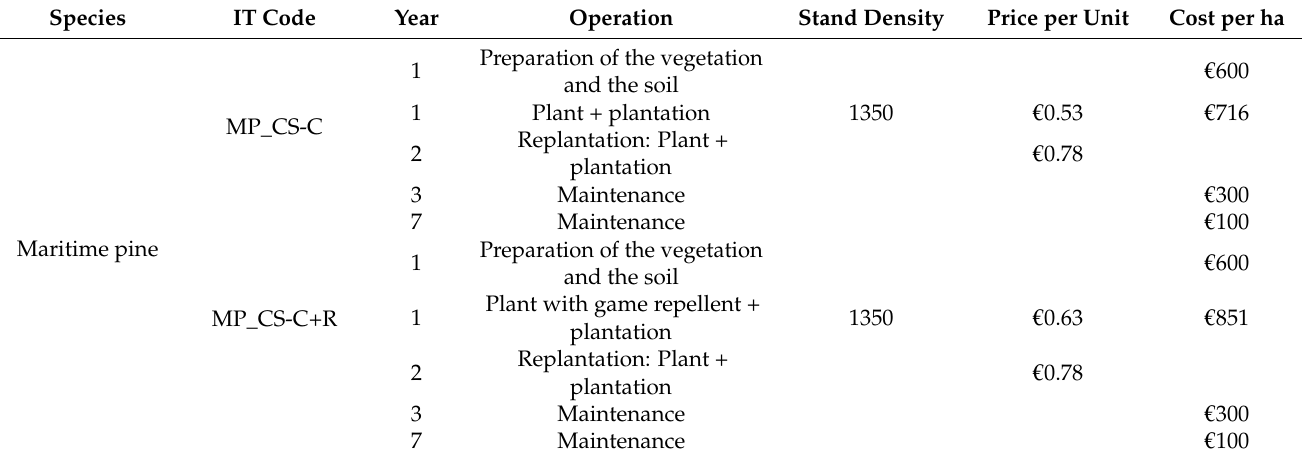
Table 2. Itinerary of plantations for maritime pine with the detailed operations associated with their year of realization and their costs (in EUR/ha). The code of the itinerary (IT code) corresponds to: (i) the species (MP for maritime pine ( Pinus pinaster Ait.)), (ii) the type of planting (CS-C for container seedlings planted with a cane), and (iii) the type of protection against game (none or R for game repellent).